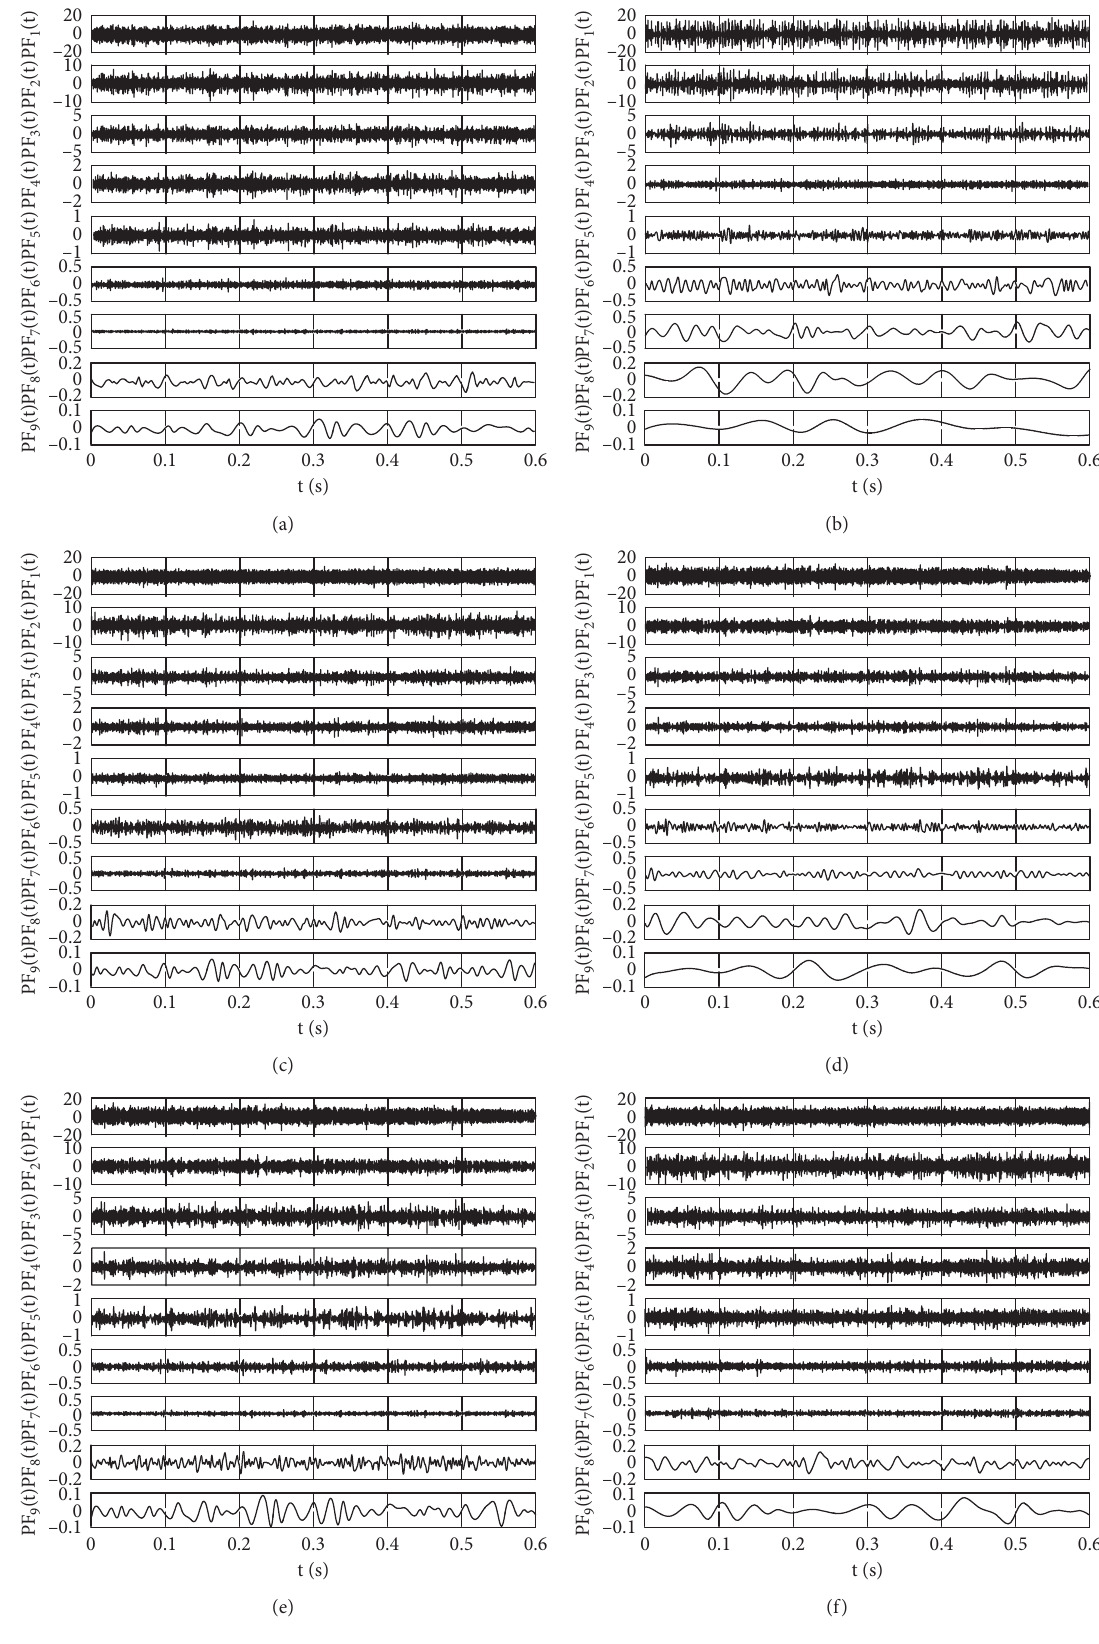
Figure 5: The double LMD extraction results. (a) ∼ (f) are the double LMD extraction results of BR, LBR, OR, LOR, IR, and LIR,